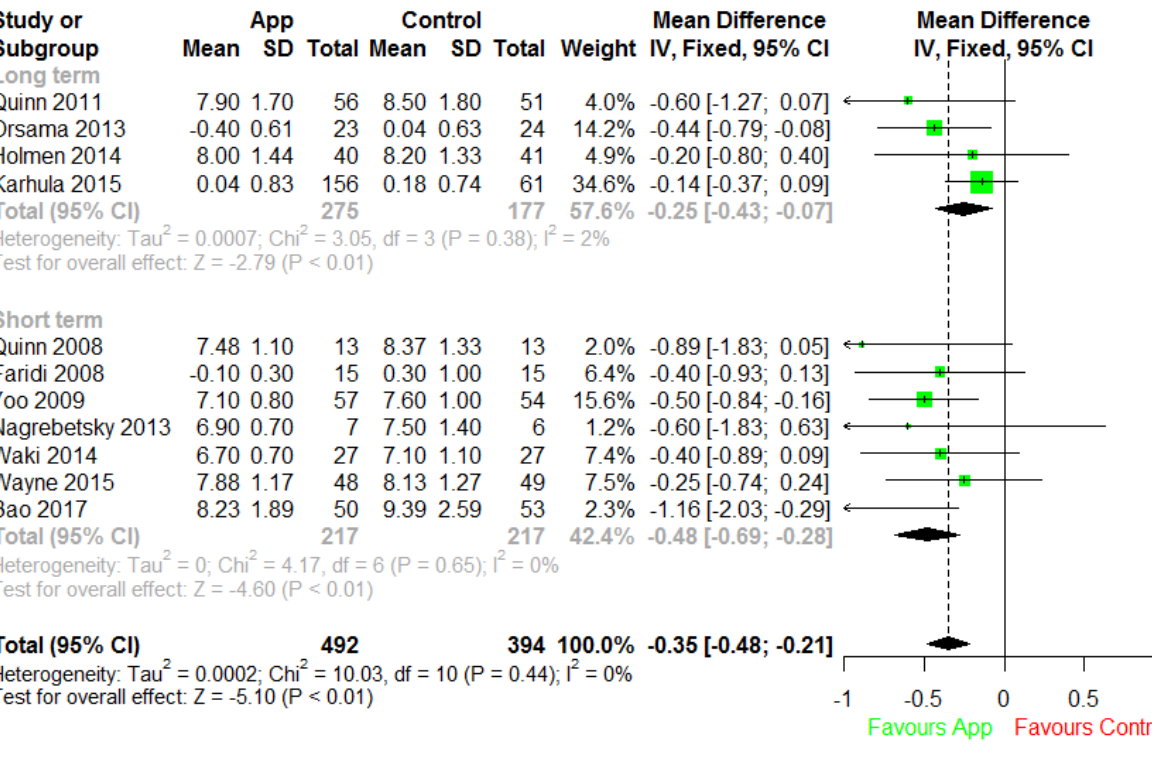
Figure 5. Forest plot of short- and long-term effects of apps for type 2 diabetes mellitus. IV: inverse variance.